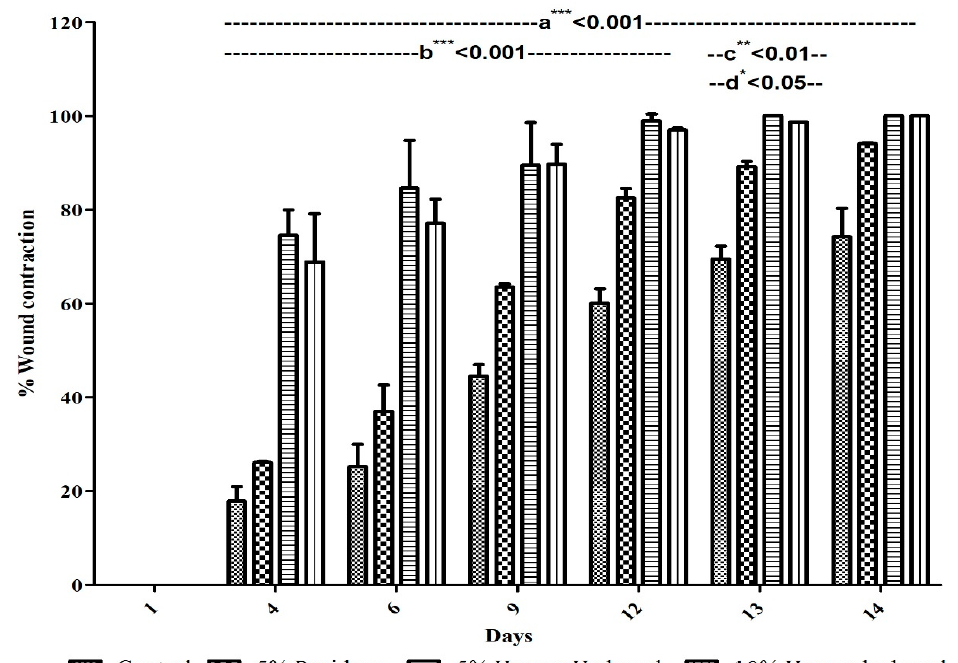
Figure 3. Potential of various n-hexane extract of M. oleifera seeds hydrogels on the healing of excision wound expressed in percentage. Mean ± SD, analyzed by Two- way ANOVA (Analysis of variance) followed by Bonferroni’s multiple comparison test post hoc analysis; a*** < 0.001 vs. control; b*** < 0.001 test drugs vs. standard until 12th day; c** < 0.01 5% hexane hydrogel vs. standard at 13th day; d* < 0.05 10% hexane hydrogel vs. standard at 13th day.